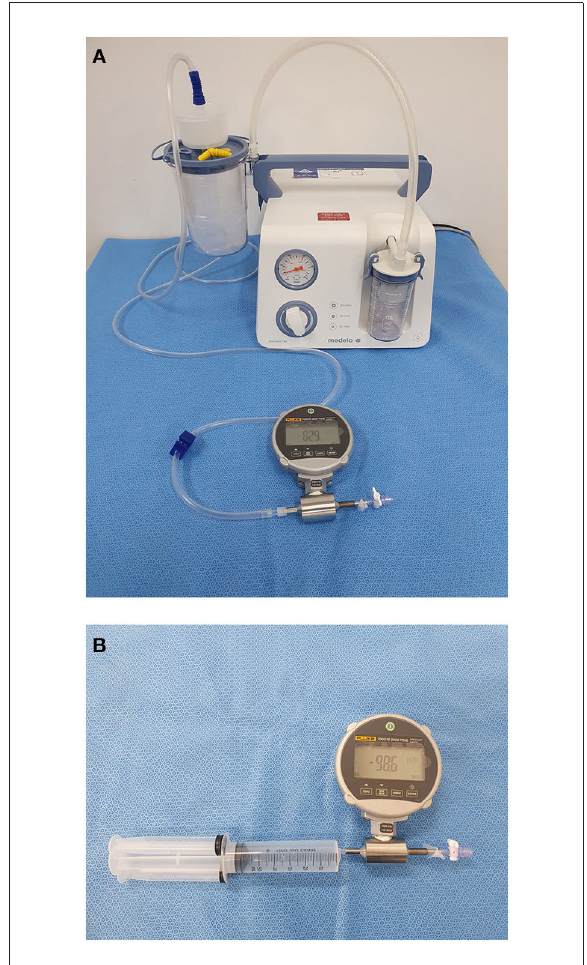
FIGURE1 In vitro measurement of vacuum pressure. (A) The pump was connected to a pressure gauge using a three-way pressure gauge inline adapter (luer lock, ISO 594-2); additionally, the system was completely closed by stopcock, which is attached at the end of the three-way adapter. (B) A 60cc syringe was connected to a pressure gauge, and a plunge was locked into